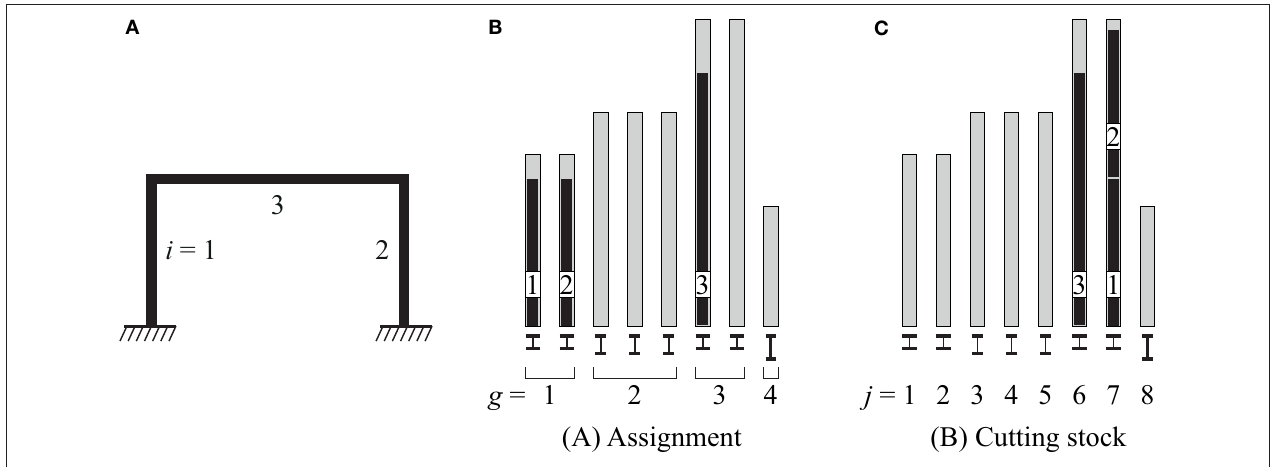
FIGURE 1 | Optimization method: (A) structure layout, (B) element stock and optimal assignment, (C) element stock and optimal cutting pattern.